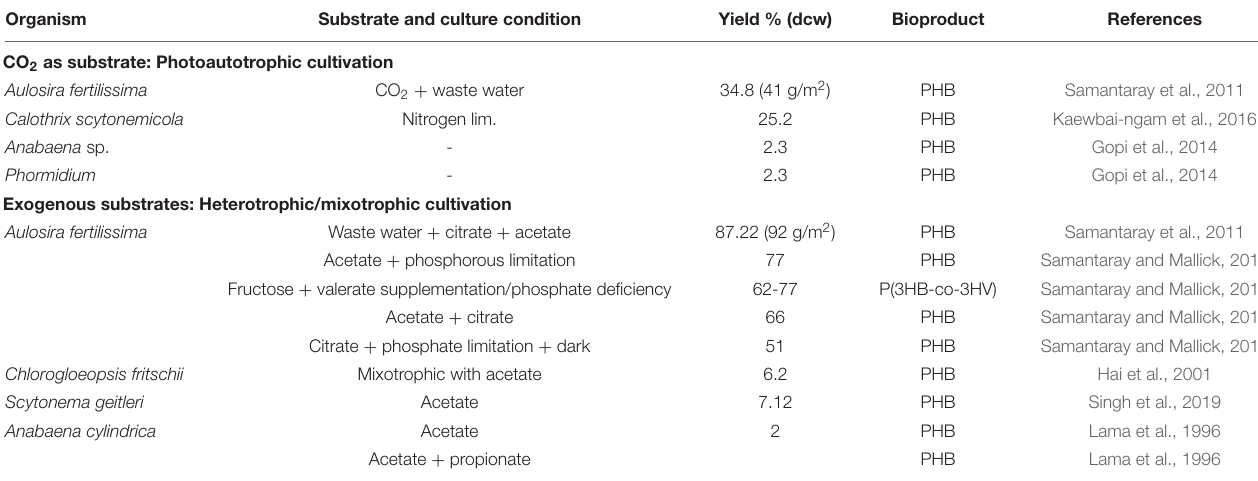
TABLE 2 | PHA production from cyanobacteria under different cultivation conditions